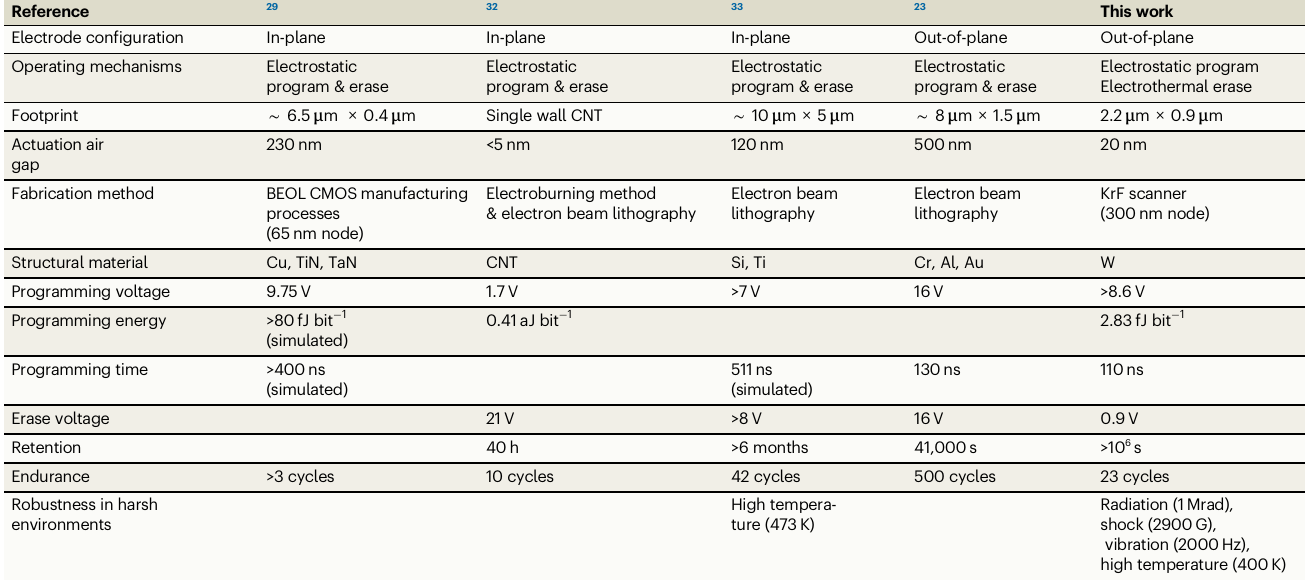
Table 1 | Comparison of NEM-NVM devices Reference Electrode con fi guration Operating mechanisms Electrostatic